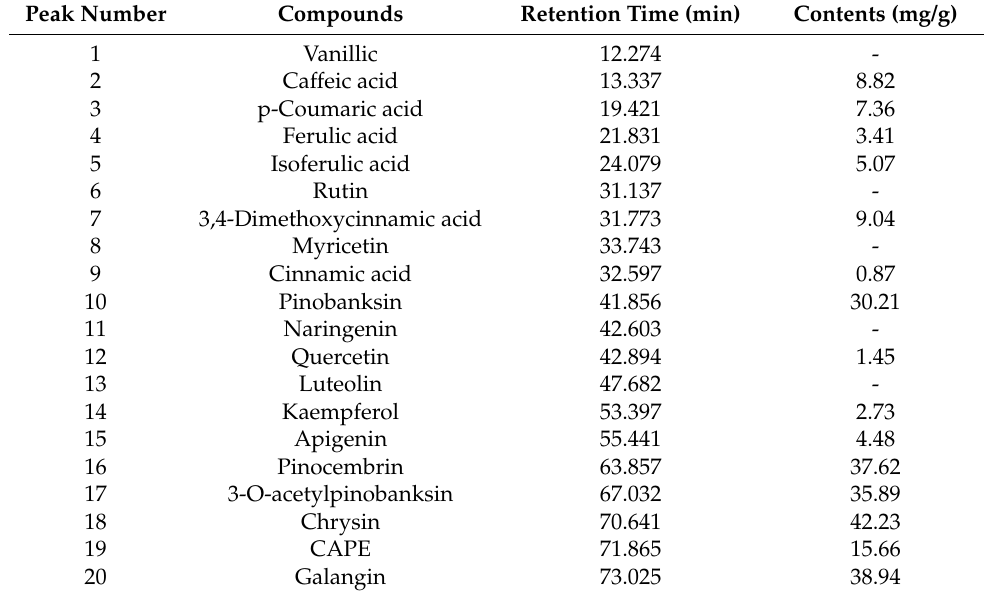
Figure 1. The HPLC chromatograms of standard solution and CP. 1: Vanillic; 2: Caffeic acid; 3: p-Coumaric acid; 4: Ferulic acid; 5: Isoferulic acid; 6: Rutin; 7: 3,4-Dimethoxycinnamic acid; 8: Myricetin; 9: Cinnamic acid; 10: Pinobanksin; 11: Naringenin; 12: Quercetin; 13: Luteolin; 14: Kaempferol; 15: Apigenin; 16: Pinocembrin; 17: 3-O-acetylpinobanksin; 18: Chrysin; 19: CAPE; 20: Galangin. Table 1. The main components identified in CP by